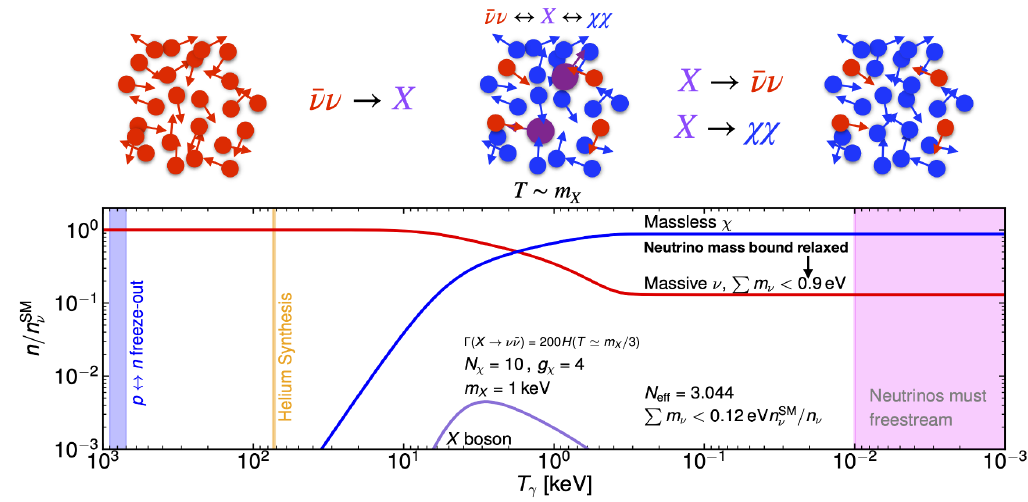
Figure 2 . Illustration of the mechanism of Farzan and Hannestad [30] to reduce the neutrino number density between BBN and recombination. We show the relative number densities of active neutrinos (red), N = 10 generations of massless sterile fermions (blue), and the mediator boson X χ with mass m = 1 keV (purple). For reference we show relevant events taking place in the early X Universe, see e.g. [48], as well as the region of temperatures at which neutrinos (or other relativistic species) should be freestreaming